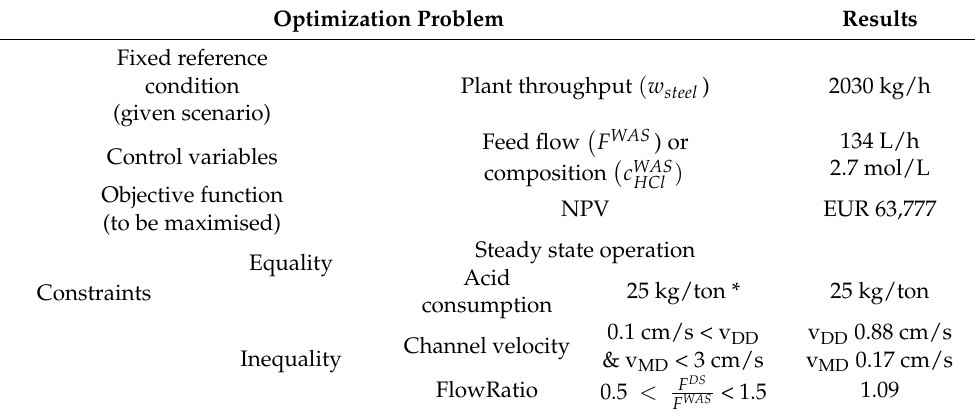
Optimization problem and results for the scenario with operating variables as control variables.